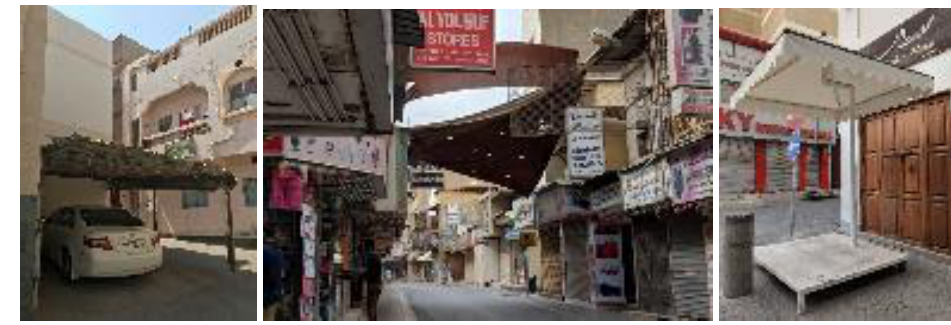
Figure 18. Shadings in many places are in ugly shape e. Infrastructure: in terms of Antennas, electric wires hanging upon building facades